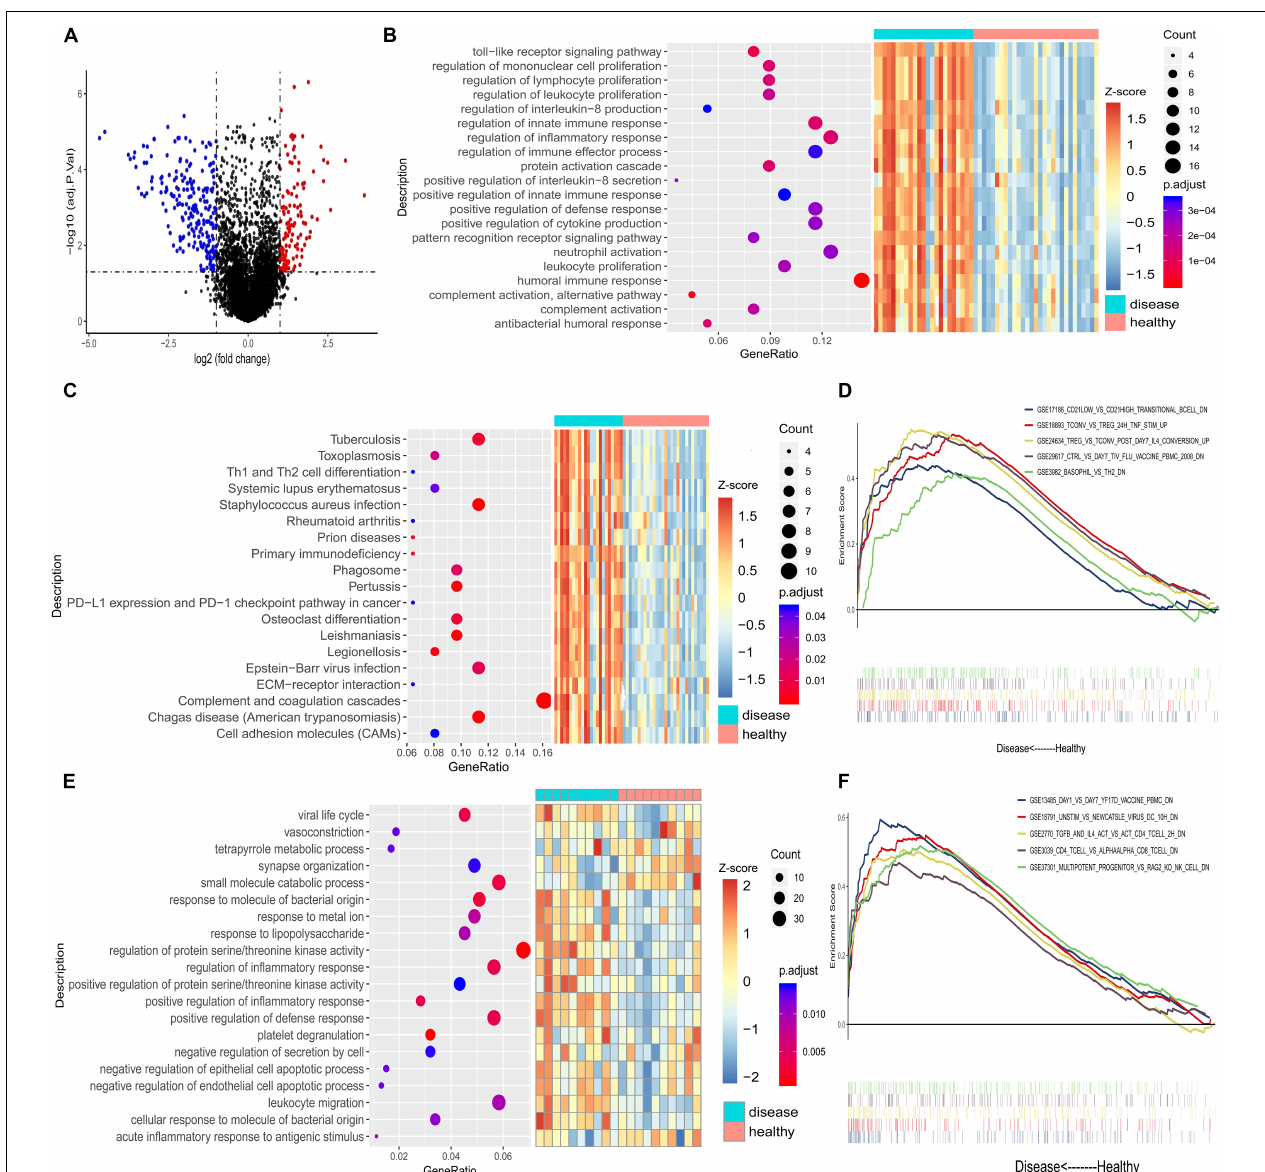
FIGURE 2 | (A) Volcano plot of the genes differentially expressed between chronic kidney disease tissue and healthy kidney tissue from humans (dataset GSE12682). Red indicates that a gene is up-regulated in chronic kidney disease, while blue indicates that it is down-regulated. (B) The 15 most significantly enriched biological processes from the up-regulated genes in GSE12682. (C) Enriched KEGG pathways for the up-regulated genes in GSE12682. (D) The five most significantly enriched gene sets in chronic kidney disease in GSE12682. (E) The 15 most significantly enriched biological processes for the up-regulated genes from Balb/c mice (dataset GSE12683). (F) The five most significantly enriched gene sets in Adriamycin-induced kidney injury in GSE12683.